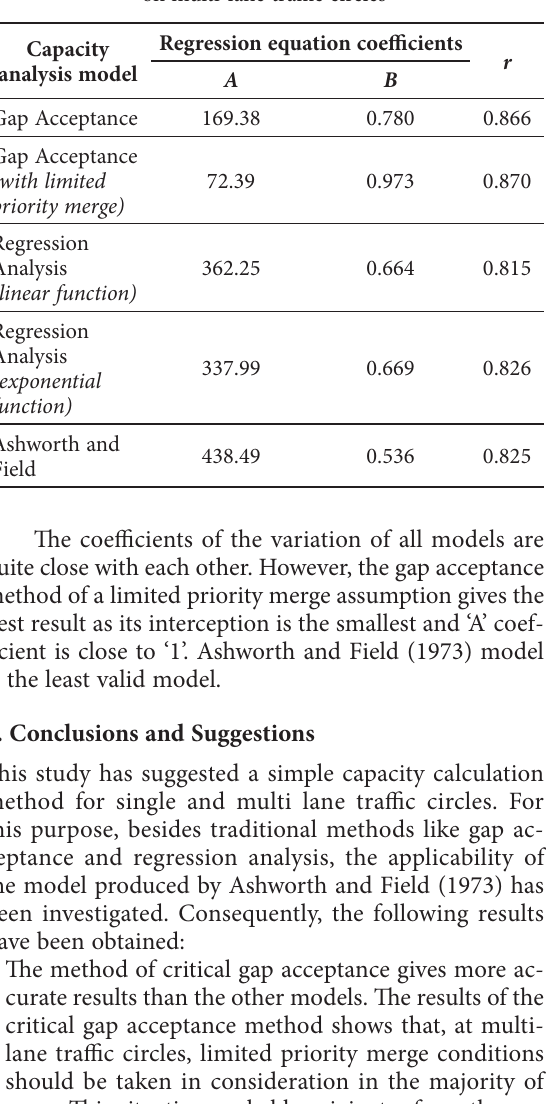
Table 5. Comparison of capacity models and observed data on multi-lane traffi c circles